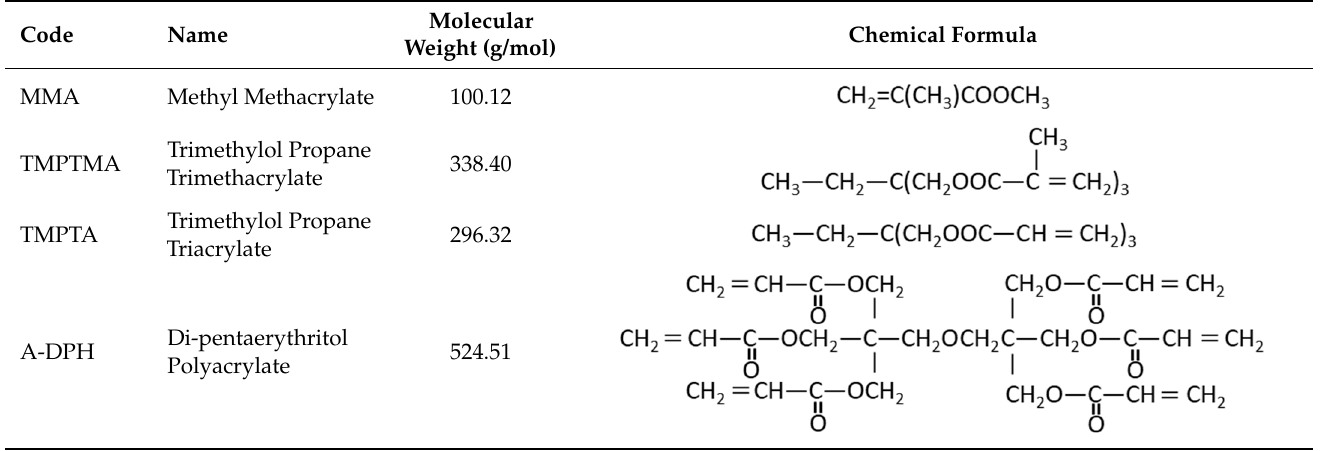
Table 1. Structural formula of substances used in this study.